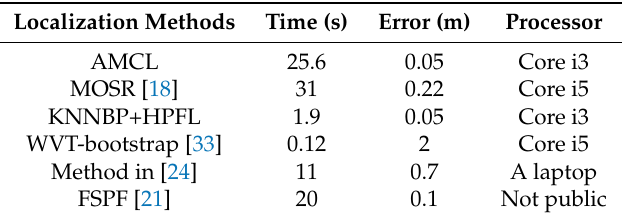
Table 3. Performance of indoor localization